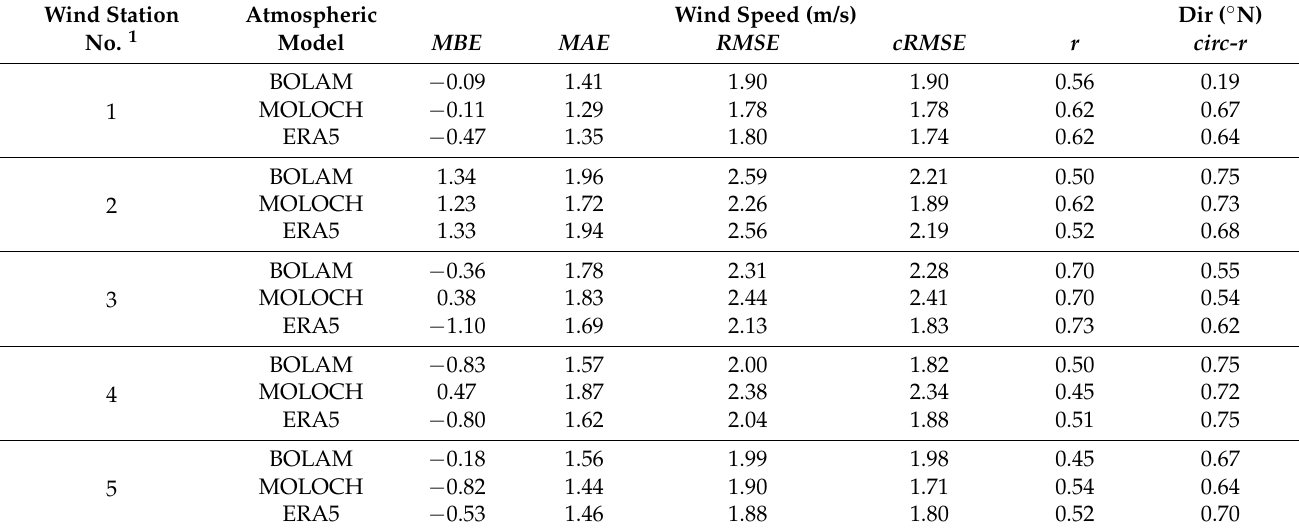
Table 9. Statistical indicators for wind speed and direction obtained for the wind speed values above the thresholds of the 33rd